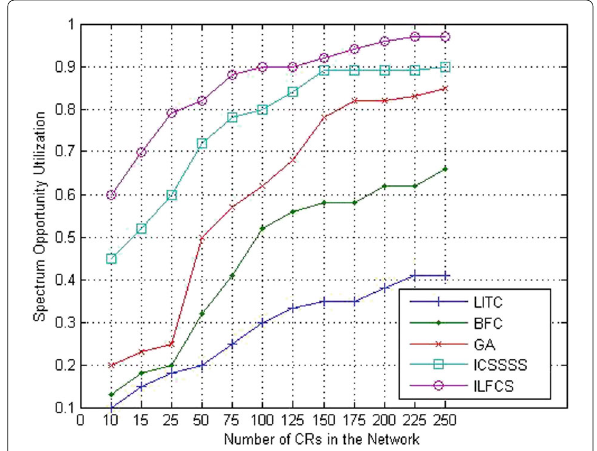
Fig. 9 Packet delivery ratio under different network density. The results of diverse simulation experiments to measure the Packet delivery ratio at different numbers of CR nodes for the BFC, LITC, GA, ICSSSS, and the ILFCS are illustrated